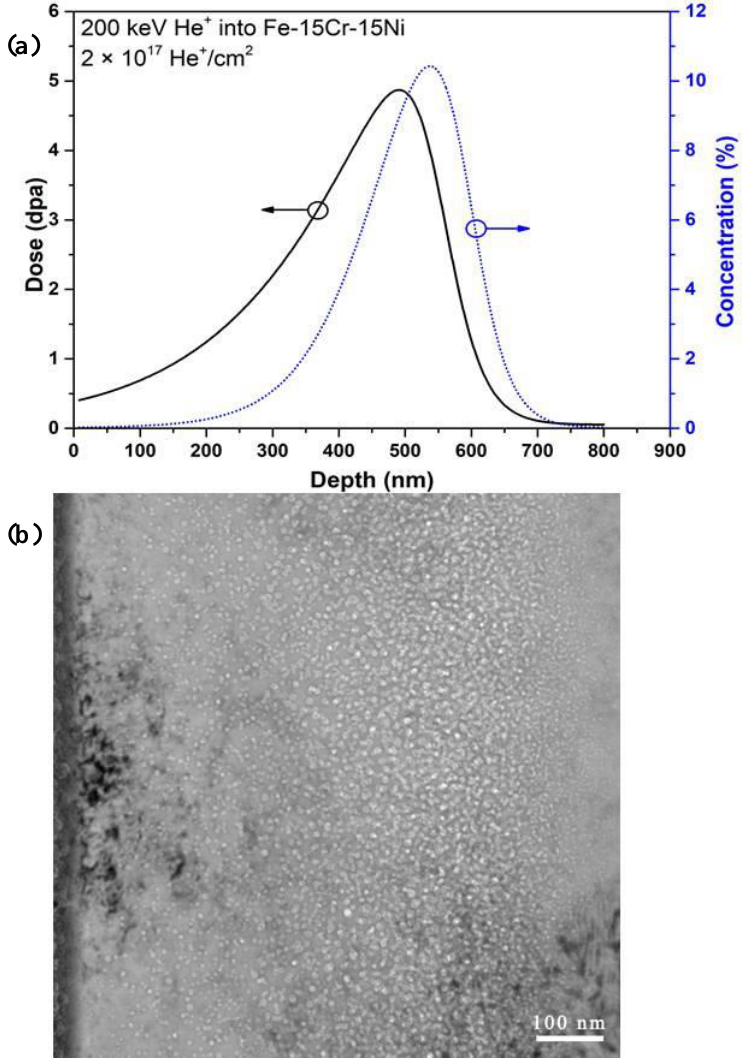
Figure 4. ( a ) The damage distribution in dose (dpa) and helium concentration for 200 keV He + irradiation to 2 × 10 17 ions cm −2 , as predicted by SRIM. ( b ) A bright-field Fresnel-type image recorded in an under-focused condition where the bubbles are shown as bright regions.